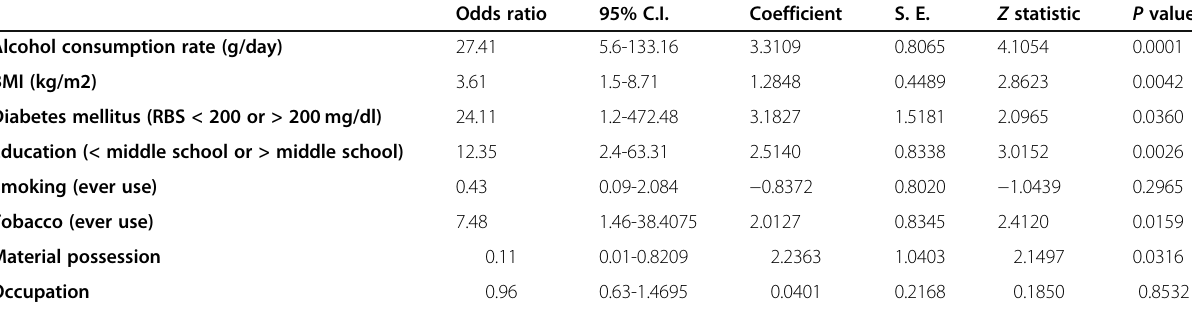
Table 3 Multivariate conditional logistic regression of risk factors for chronic liver disease Odds ratio 95% C.I. S.